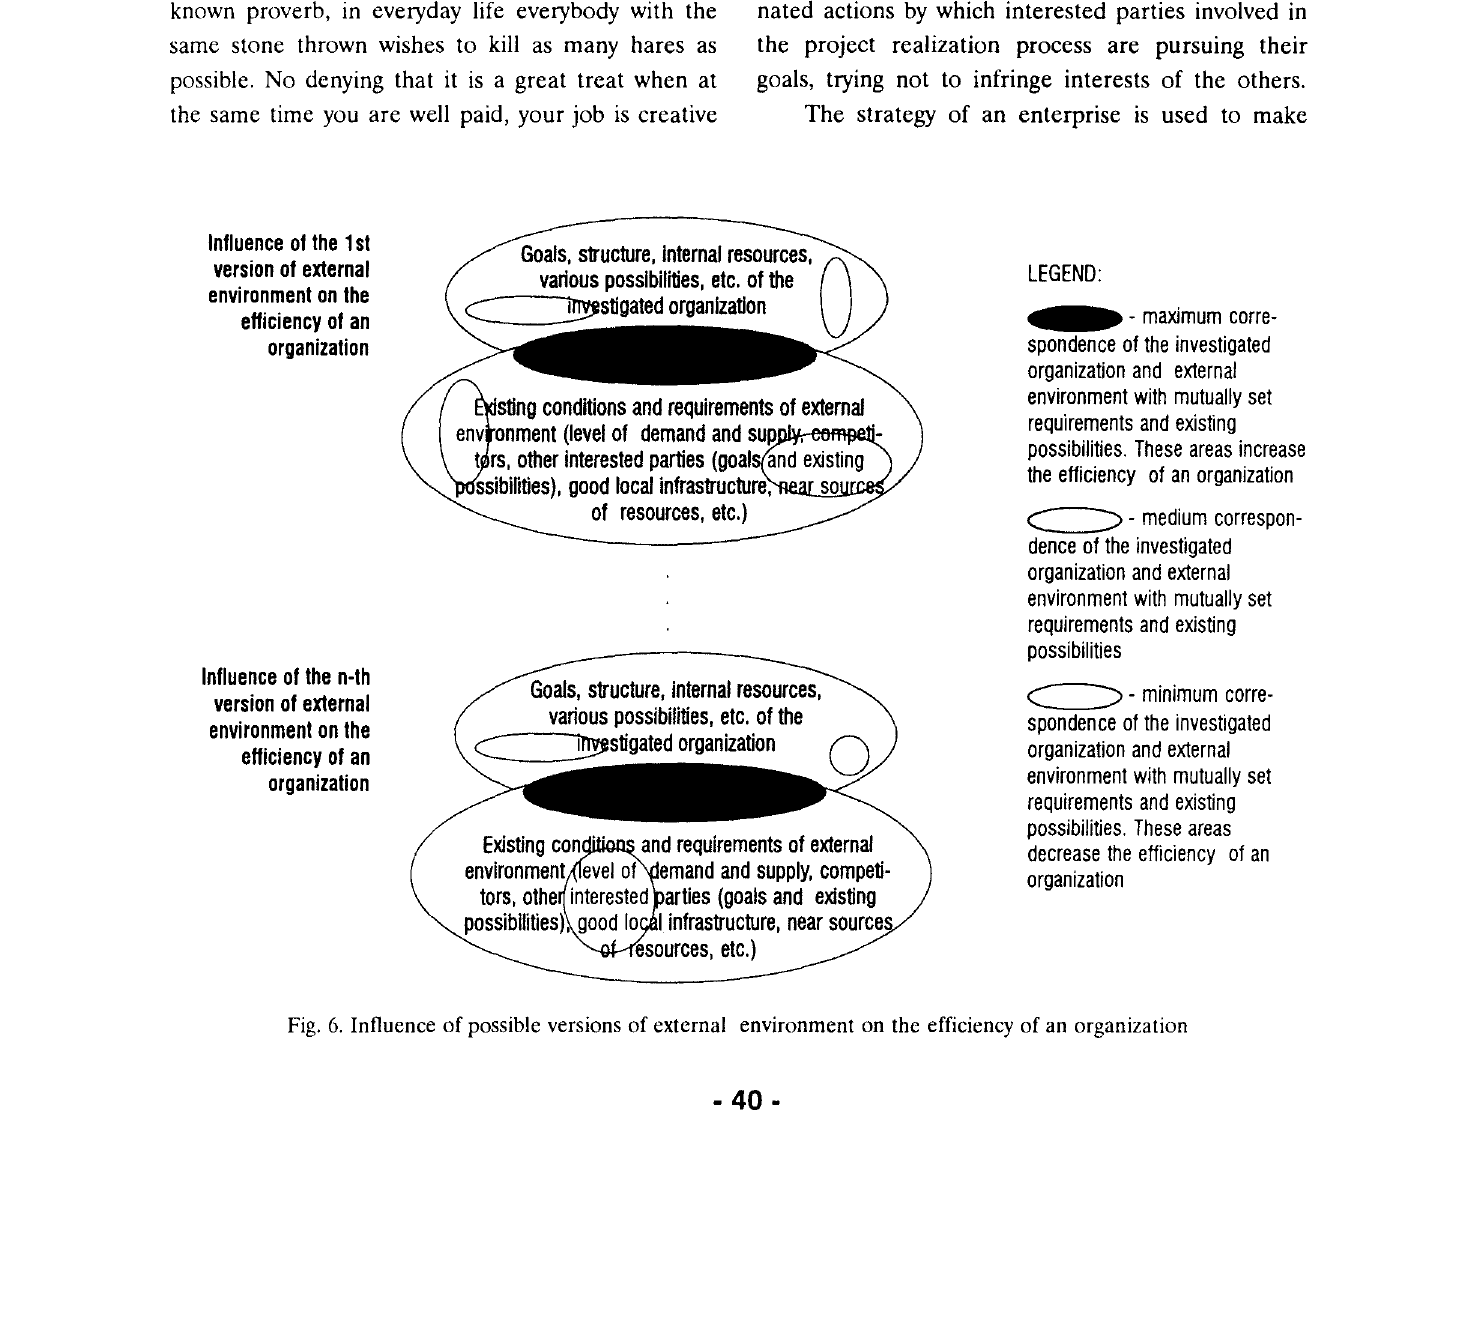
Fig. 6. Influence of possible versions of external environment on the efficiency of an organization -